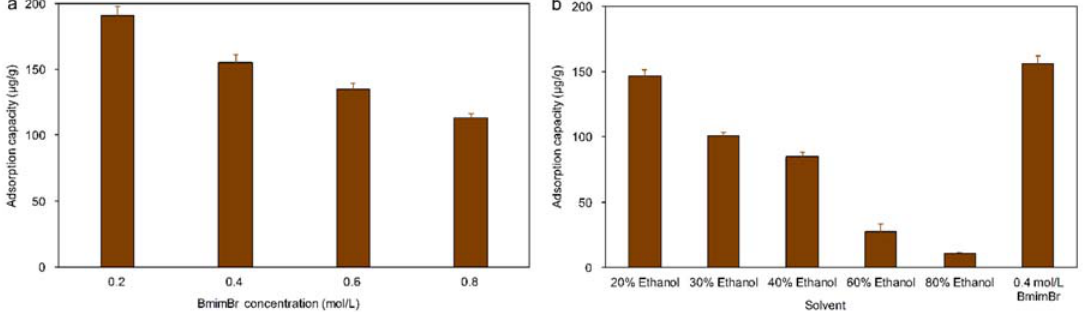
Figure 3. The effect of concentration of BmimBr ionic liquid ( a ) and ethanol ( b ) on the absorption capacity of aucubin on HPD 850.